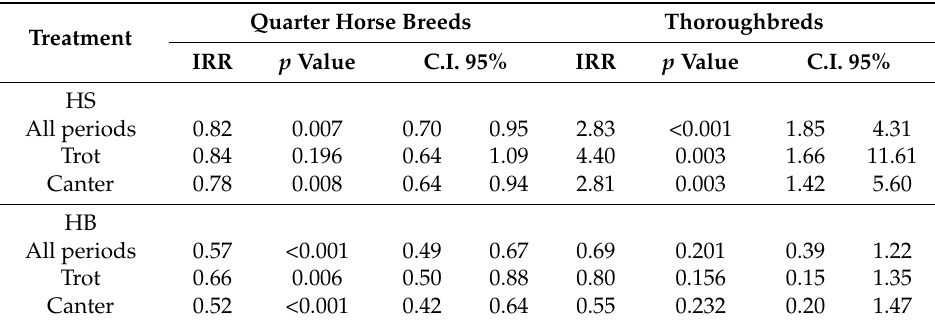
Table 4. Effect of treatment and breed on incidence rate ratio (IRR) of median headshakes/minute at the trot and canter and all periods. IRR, p value and confidence intervals. p < 0.05 was considered